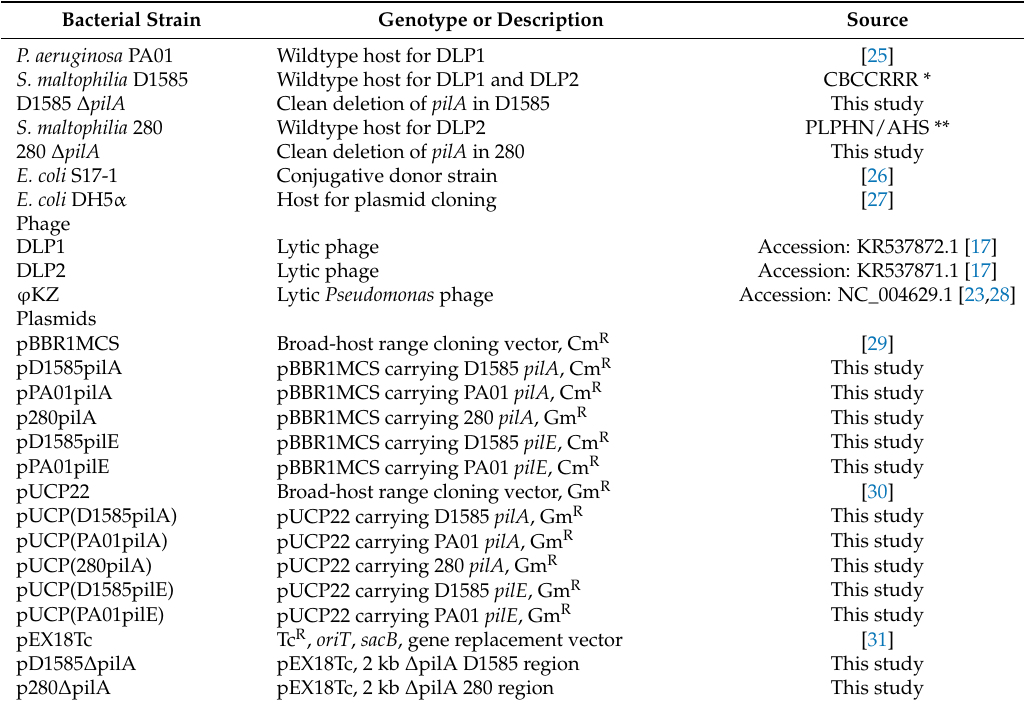
Table 1. List of bacterial strains, phages and plasmids used in this study. Bacterial